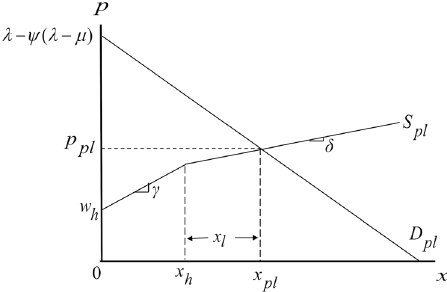
Fig. 6 Equilibrium conditions in Scenario III. This fi gure depicts the equilibrium conditions for Scenario III when the undifferentiated low-quality product coexists with its higher quality counterpart produced by more ef fi cient producers.